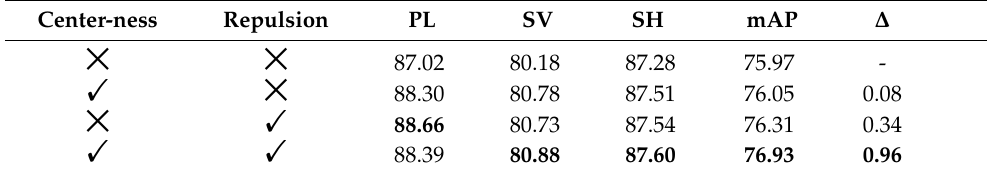
Table 7. Performance evaluation on center-ness quality assessment and repulsion constraint. PL, SV, and SH denote the categories of plane, small vehicle, and ship, respectively. All the experiments adopt ResNet-50 with FPN as the backbone. ‘ (cid:33) ’ and ‘ (cid:35) ’ in the Center-ness and Repulsion columns denote the results with or without the corresponding constraint, respectively. We adopted ConvexGIoULoss for regression loss if the repulsion constraint is not applied. The best result is bolded in each